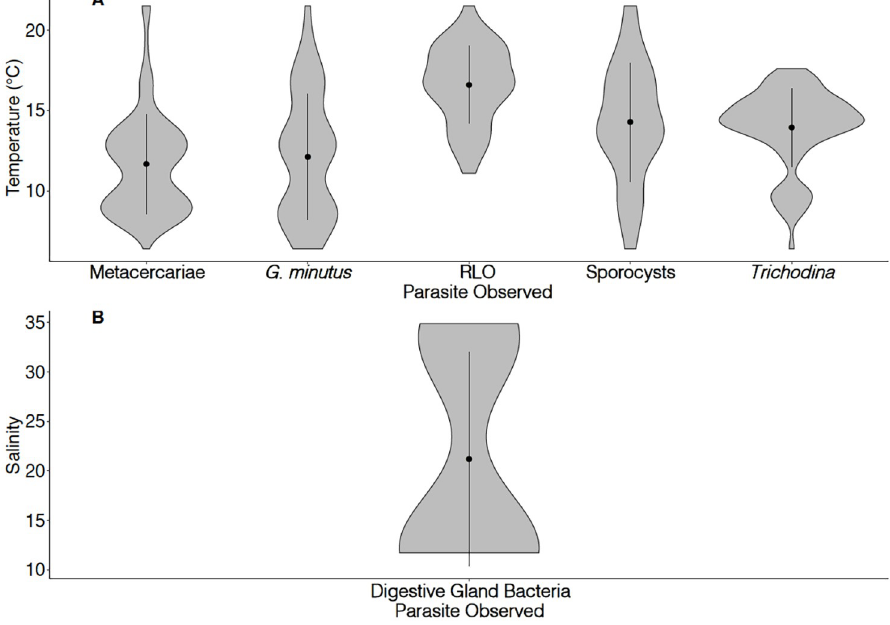
Fig 6. Violin plots (visualising the kernel probability density), demonstrating the relationship between the presence of pathogens and (A) seawater temperature and (B) salinity, at all sites combined. Mean ± 1 SD of salinity/temperature is represented by the vertical line and point within the violin